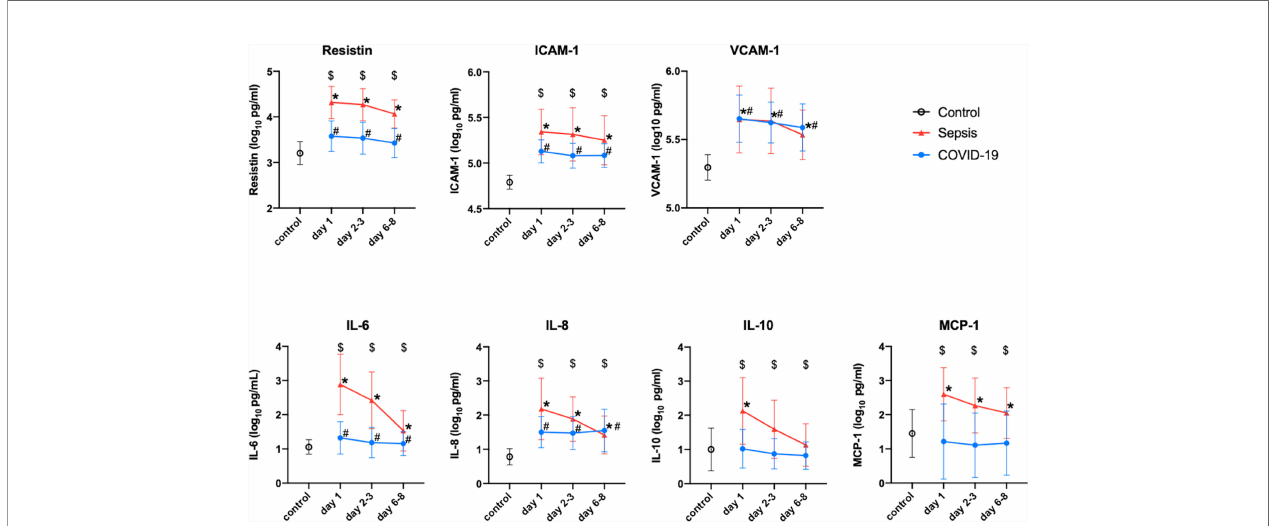
FIGURE 3 | Change in the resistin, ICAM-1, VCAM-1, IL-6, IL-8, IL-10 and MCP-1 levels of Osaka cohort 2. These protein levels were transformed to common logarithmic values to normalize the data distribution. All values are expressed as the mean ± SD. (A) * indicates a signi fi cant difference in these proteins between the control and sepsis patients. # indicates a statistically signi fi cant difference between the control and COVID-19 patients on each day ( P < 0.05). $ indicates a statistically signi fi cant difference between the sepsis patients and COVID-19 patients. COVID-19, coronavirus disease 2019; ICAM-1, intercellular adhesionmolecule 1; IL, interleukin; MCP-1, monocyte chemotactic protein 1; SD, standard deviation; VCAM-1, vascular cell adhesion